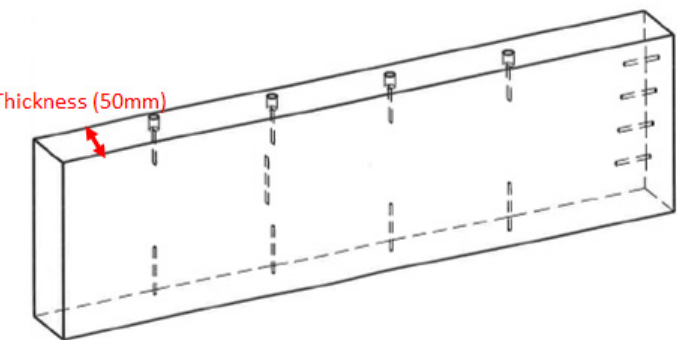
Figure 13. Specimen used for the following experimental validations.